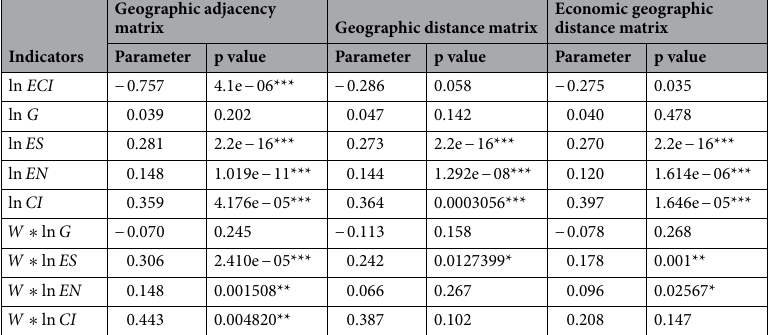
Economic geographic distance matrix